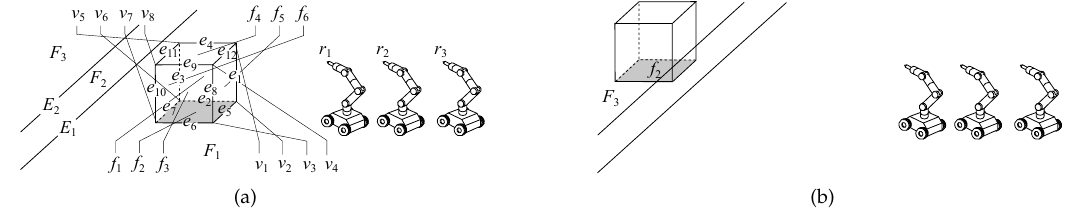
Figure 13. ( a ) Initial mode and ( b ) target final mode. Targeted object for manipulation is cuboid. There is a step in the environment. We used six pusher robots to bring the cuboid on the